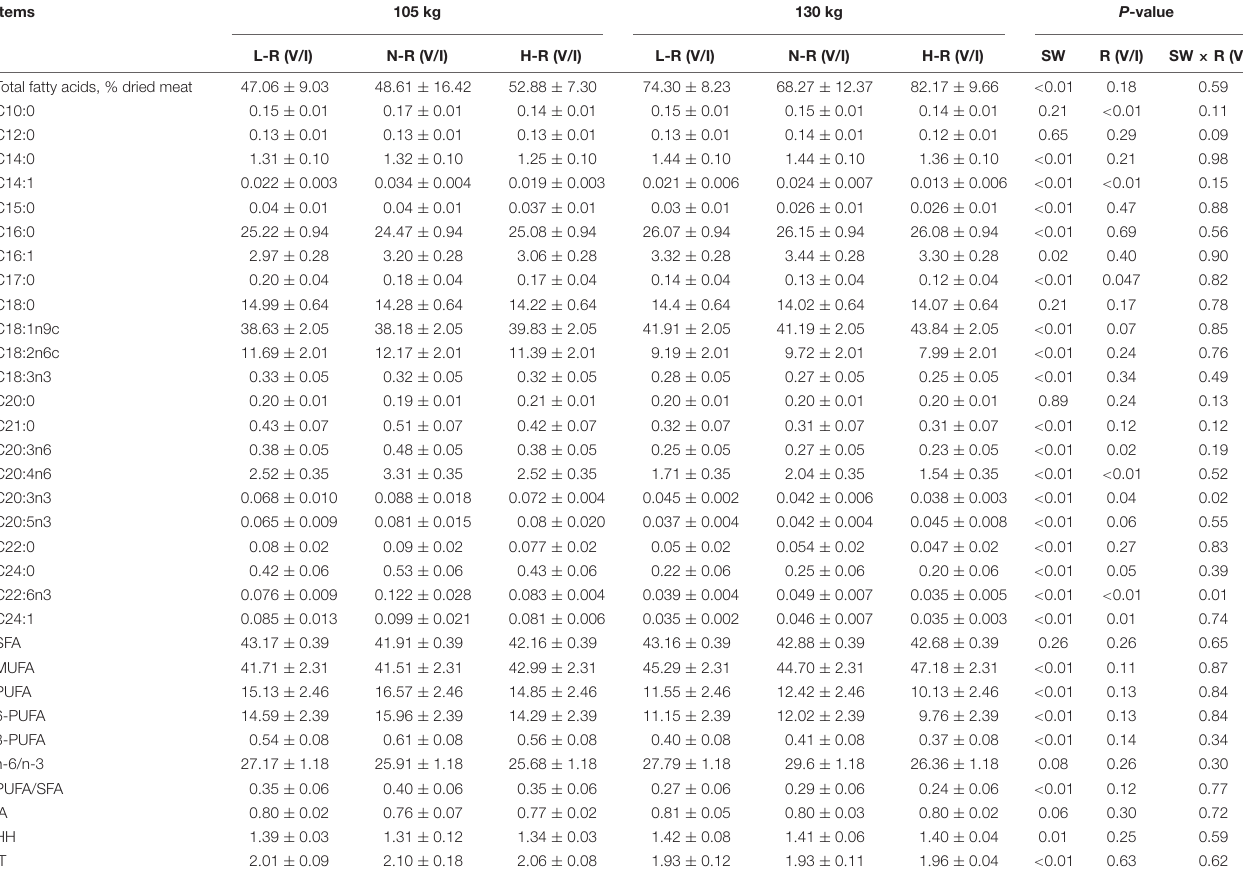
TABLE 7 | Effect of dietary R (V/I) and slaughter weight on fatty acids composition (% of total fatty acid) of fresh meat in finishing pigs ( n = 6). Items